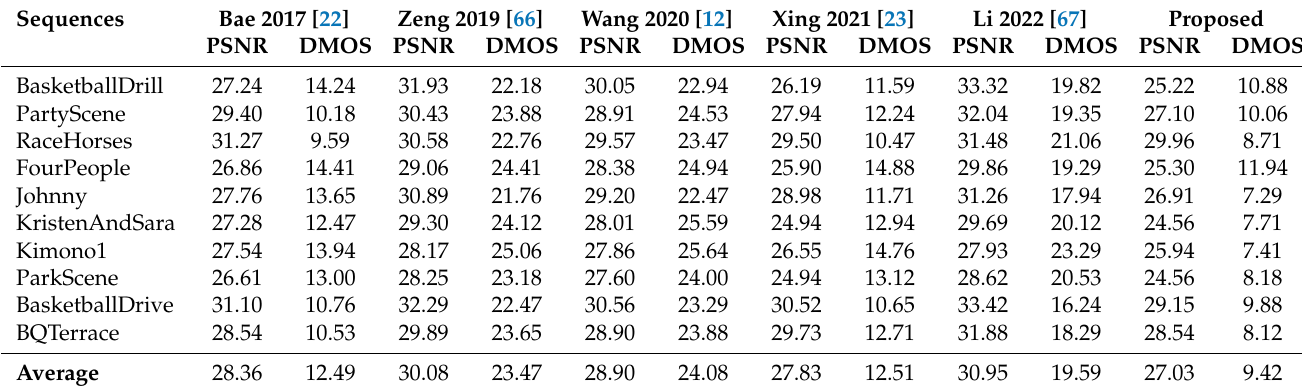
Figure 15. ( a ) Average PSNR values in Table 1 for 832 × 480, 1280 × 720, and 1920 × 1080; ( b ) Average DMOS values in Table 1 for 832 × 480, 1280 × 720, and 1920 × 1080; ( c ) Average VMAF scores in Table 2 for 832 × 480, 1280 × 720, and 1920 × 1080 [12,22,23,66,67]. Table 1. Performance comparison of different JND models.